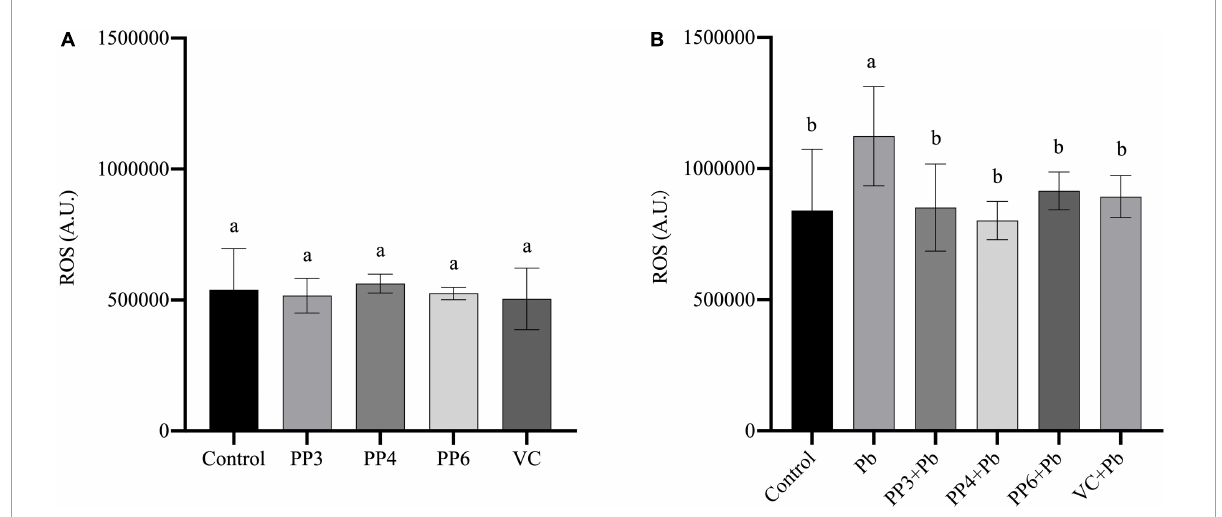
FIGURE2 Effects of PP3, PP4, PP6 and VC on intracellular ROS in PC12 cells. (A) PC12 cells incubated with PP3, PP4, PP6, and VC for 4 h. (B) PC12 cells pre-incubated with PP3, PP4, PP6, and VC for 4 h, then treated with lead for 24 h. The valued of the bars indicates the means ± SD ( n = at least 3). Different superscript letters indicate differences ( P <